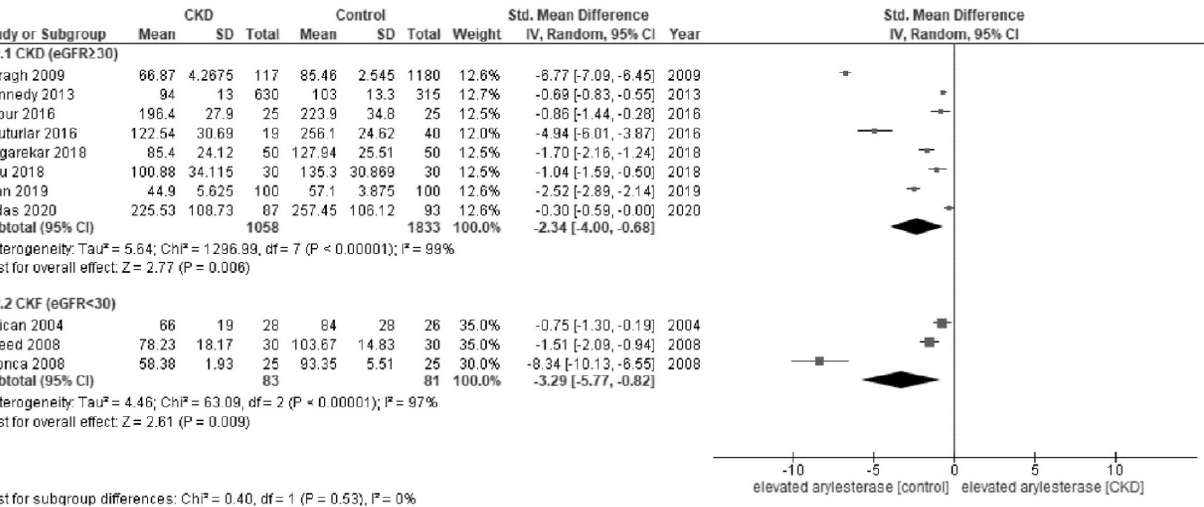
Figure 5. Forest plot of arylesterase activity stratified by the CKD stages